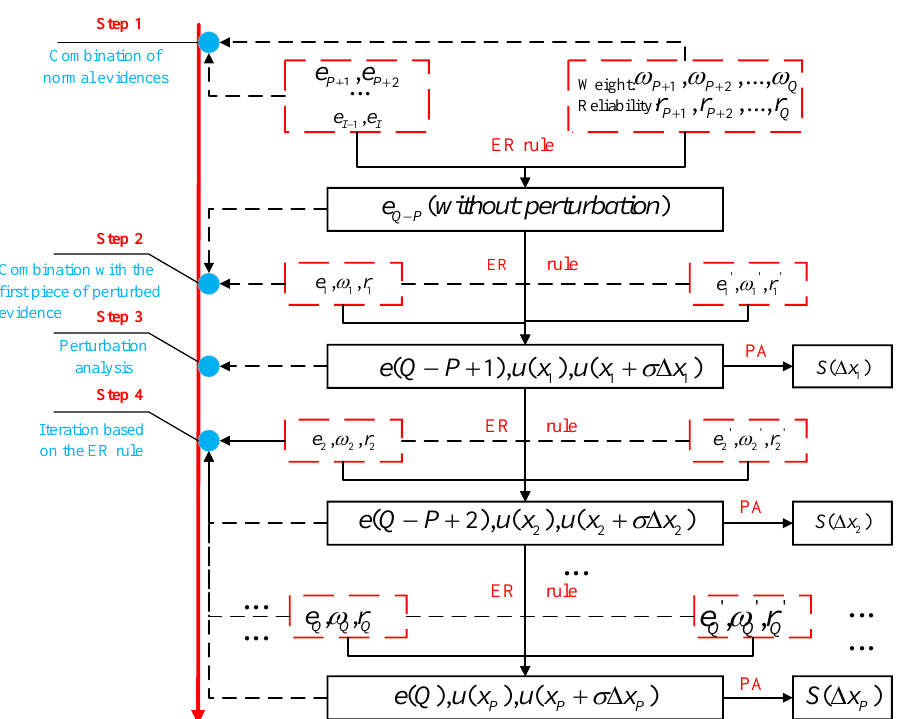
Figure 3. The assessment process of the ER rule and perturbation analysis.